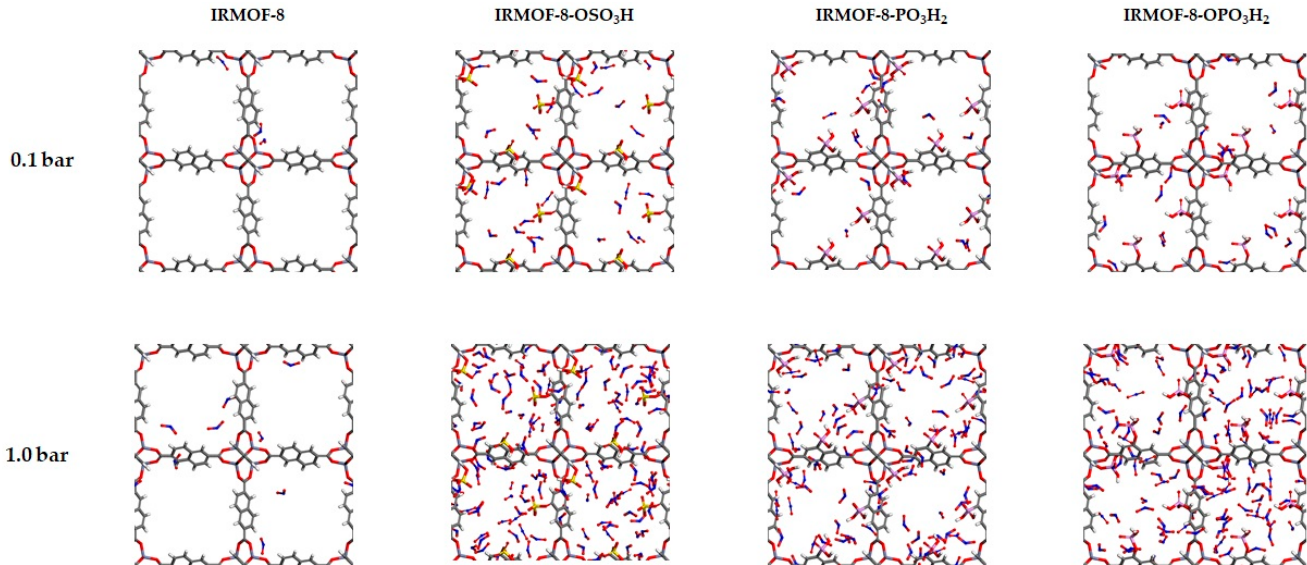
Figure 5. Snapshots for the IRMOF-8, IRMOF-8-X (X: -OSO3H, -PO 3 H 2 , -OPO 3 H 2 ) from the GCMC at 298 K-0.1 bar and 298 K-1.0 bar.